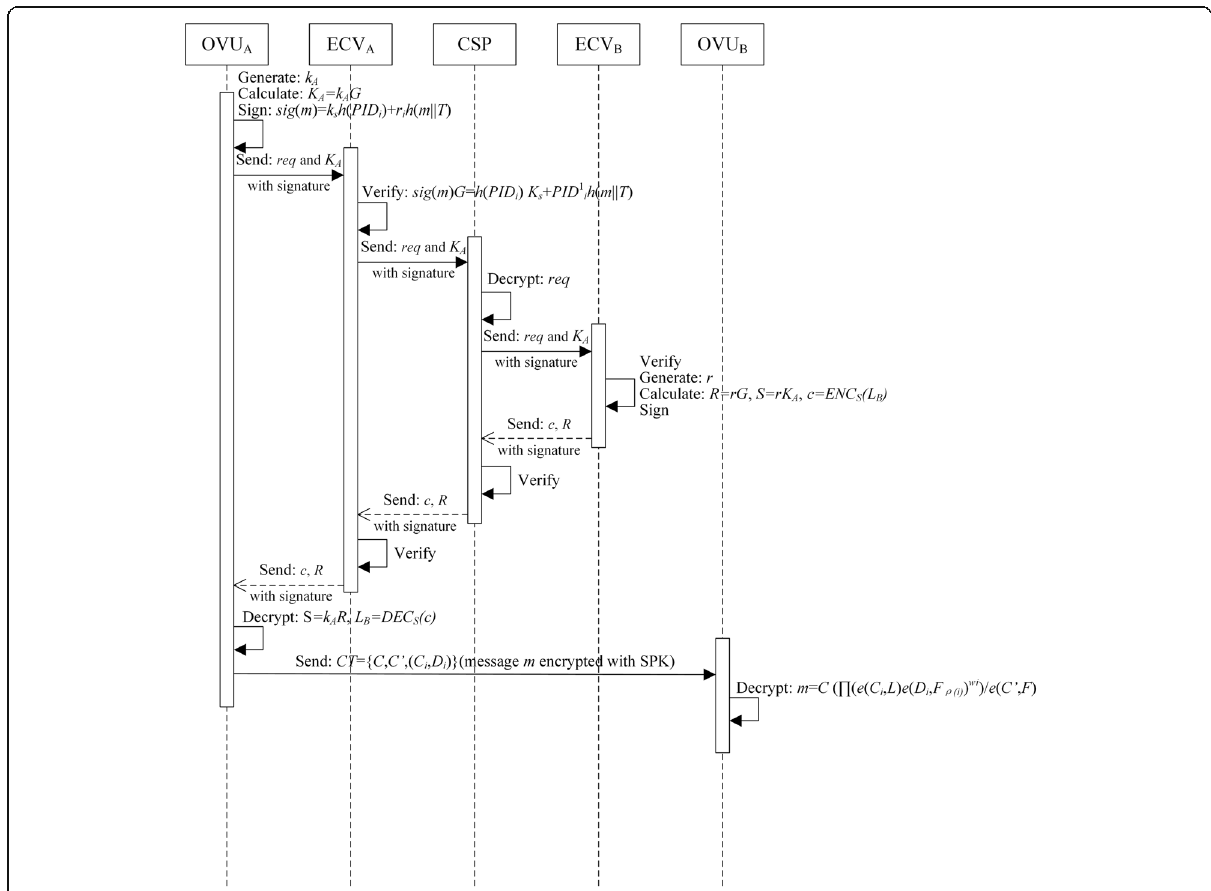
Fig. 2 Operations and interaction process of proposed